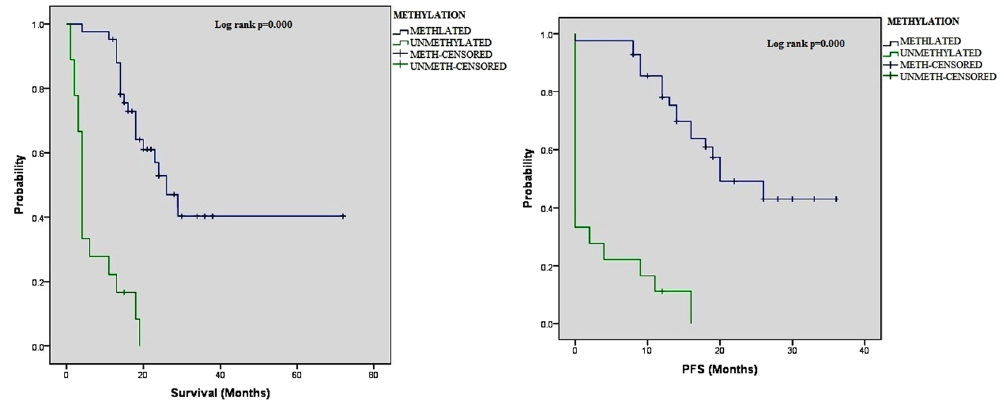
Figure 2. Association of MGMT promoter methylation with overall survival (OS) and Progression Free survival (PFS) of glioma patients as shown by KM analysis.